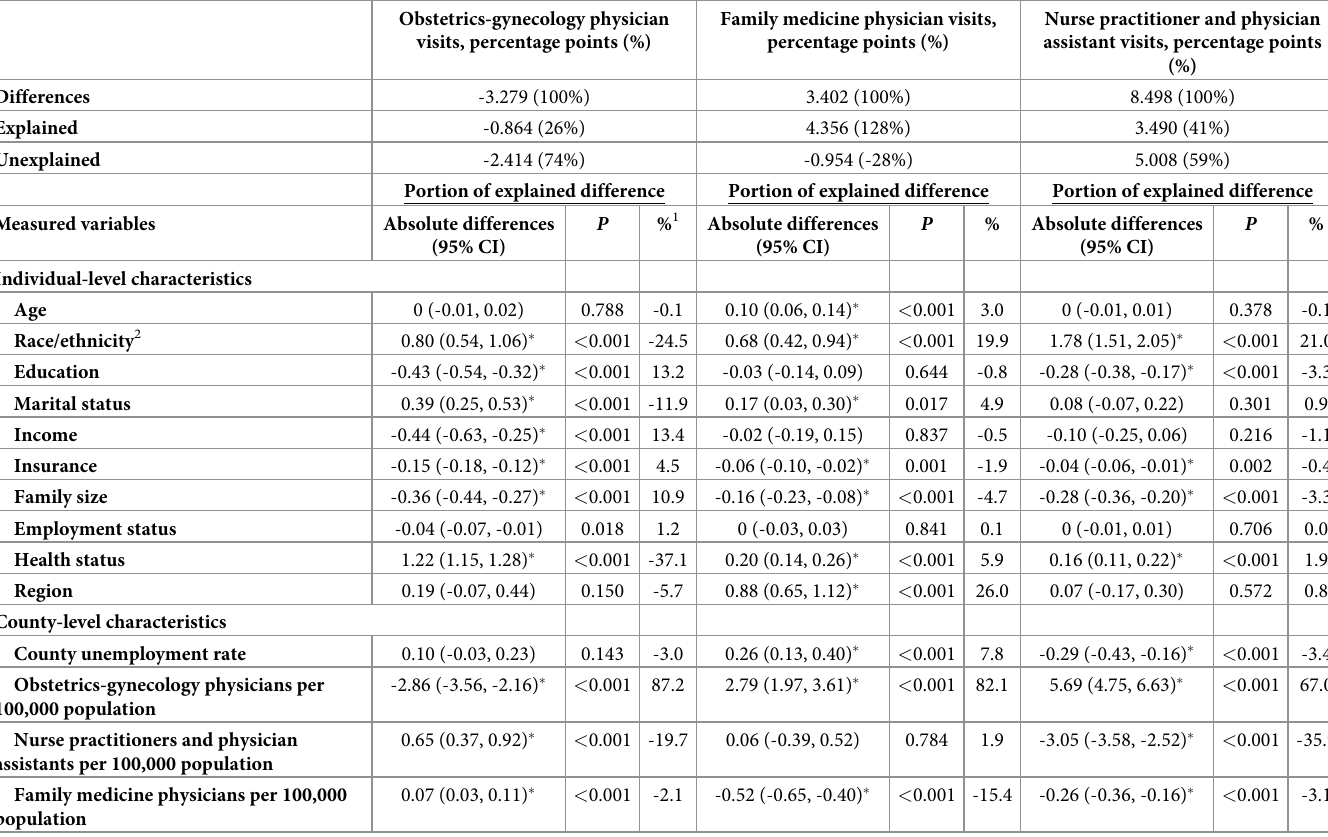
Table 5. Fairlie non-linear decomposition results for rural/urban disparities in obstetrician-gynecologist and nurse practitioner/physician assistant visits among women age 18 to 44. Obstetrics-gynecology physician visits, percentage points